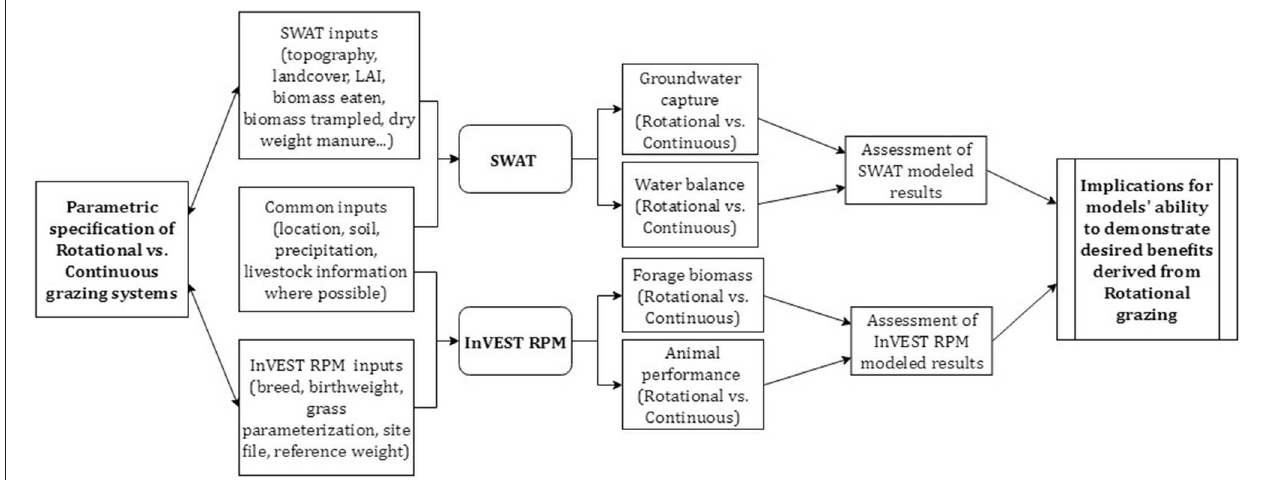
FIGURE 1 | Modeling and analysis workflow. Models share common inputs where feasible but are run without feedbacks. SWAT examines a single grazing characterization represented in a spatially explicit manner on the Ucross landscape, while InVEST RPM is run to explore various management strategies on a single representative grazing area. Both models are run under rotational and continuous management to allow a focus on the impact of management